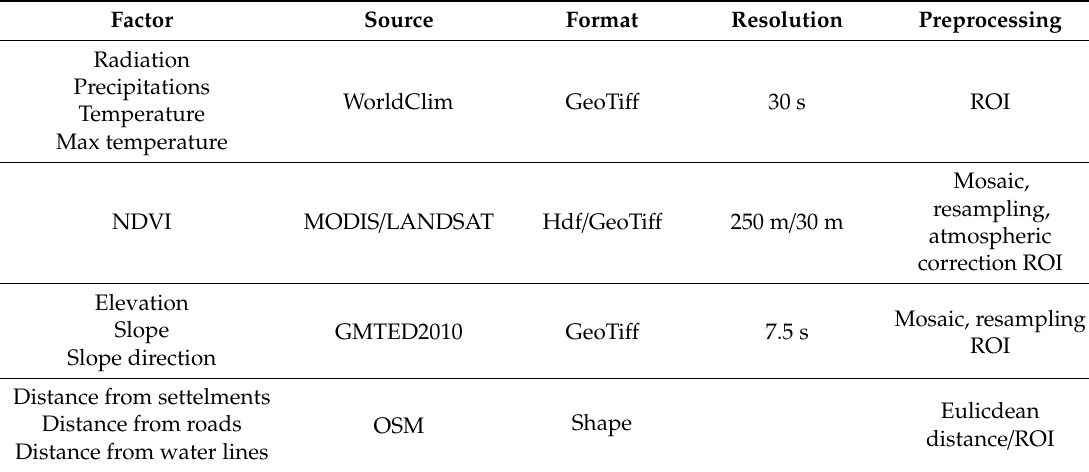
Table 1. Technical description of the